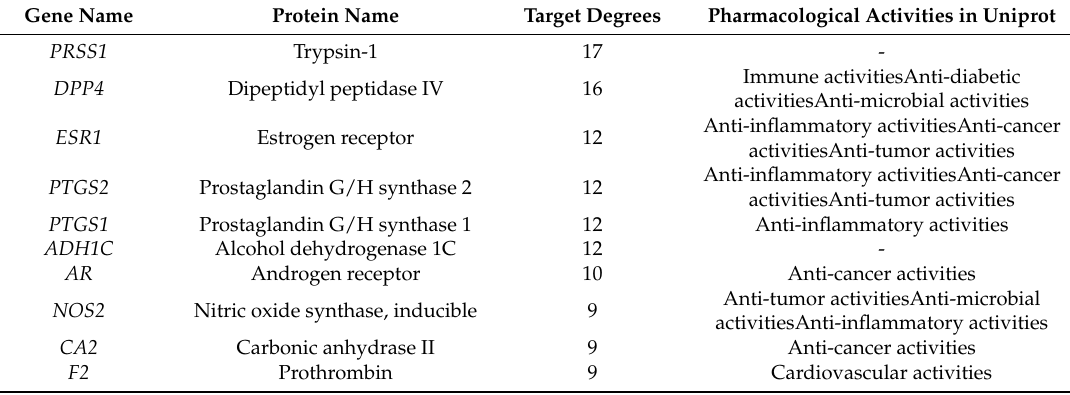
Table 1. Top 10 targets in the compound–target (CT) network and pharmacological activity of each